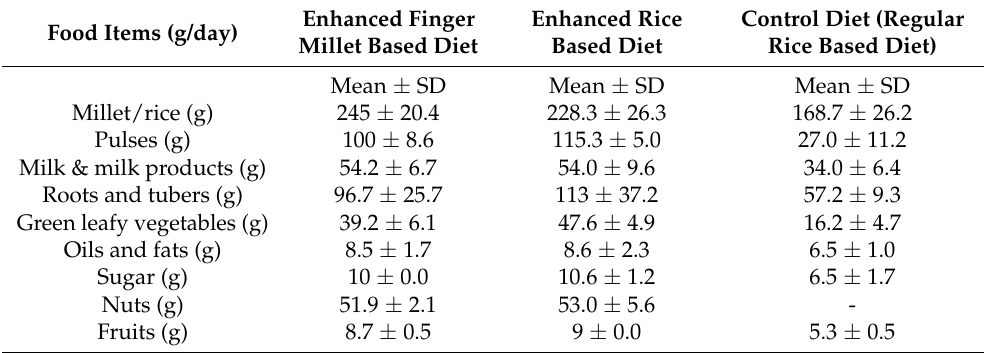
Table 3. Quantity of food items fed per day to groups consuming enhanced finger millet, enhanced rice and regular rice